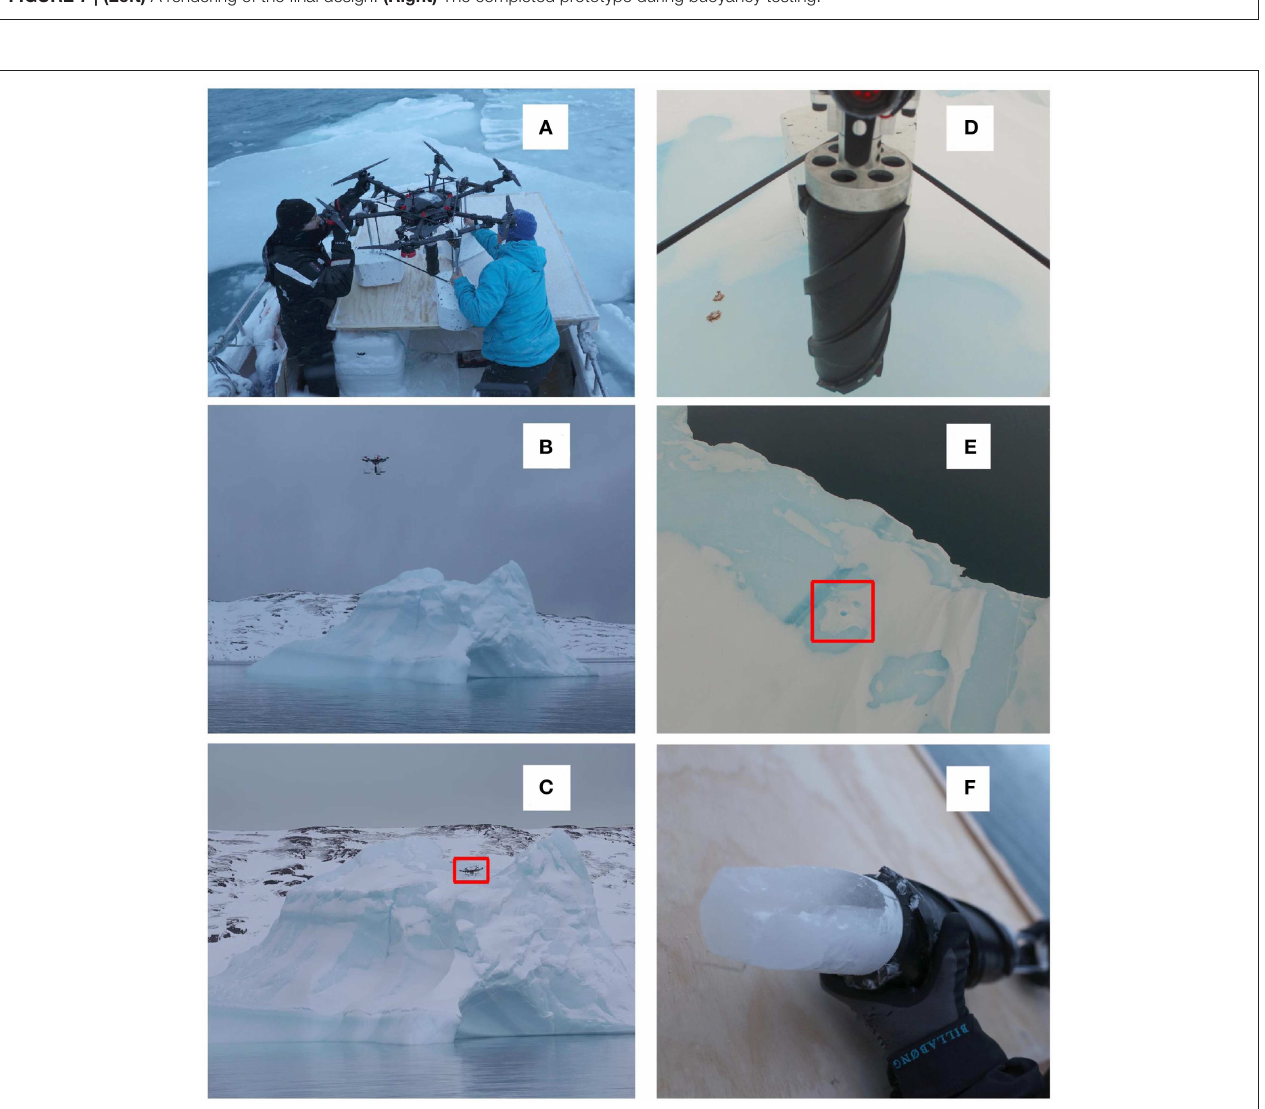
FIGURE 8 | (A) Preflight checks on the plywood landing platform (those pictured are coauthors; image used with their consent). (B) IceDrone approaching the iceberg and preparing to land. (C) IceDrone landed on top of the iceberg (red square). (D) IceDrone drilling into the top of the iceberg. (E) The hole (red square) was clearly visible after takeoff. (F) Removing the ice sample using the extraction